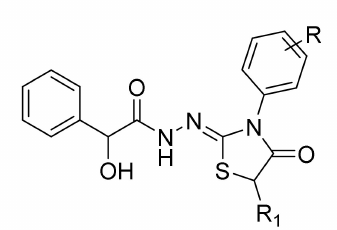
Figure 1. The general chemical structures of novel compounds 3a–3o and 4a–4k.